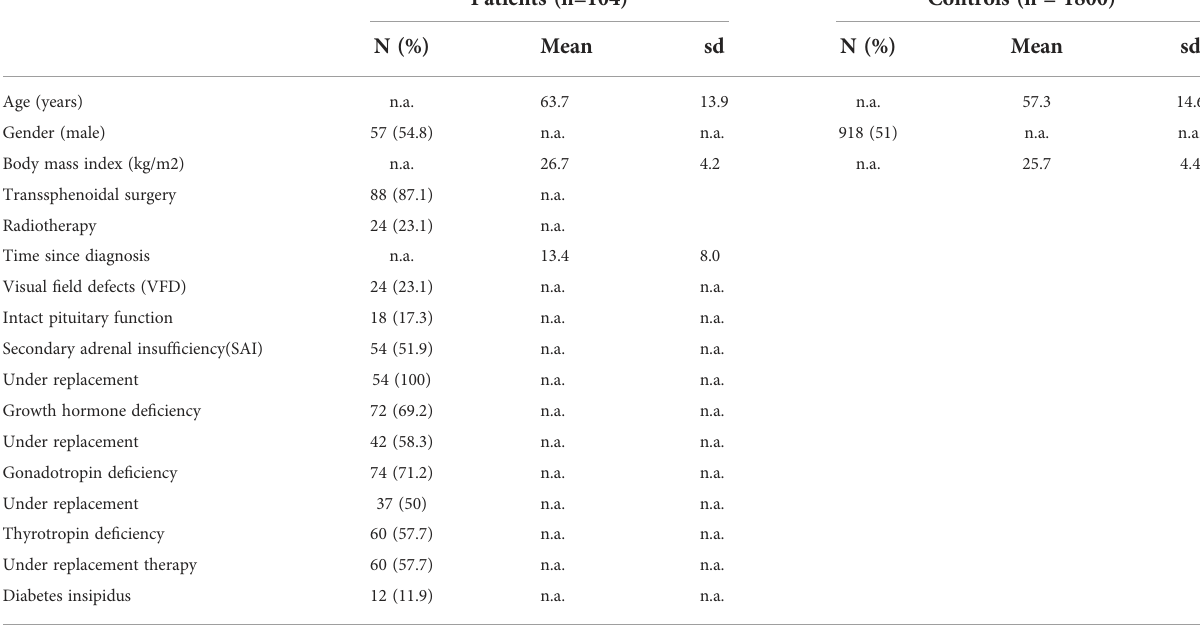
TABLE 1 Baseline and disease characteristics of patients and controls.